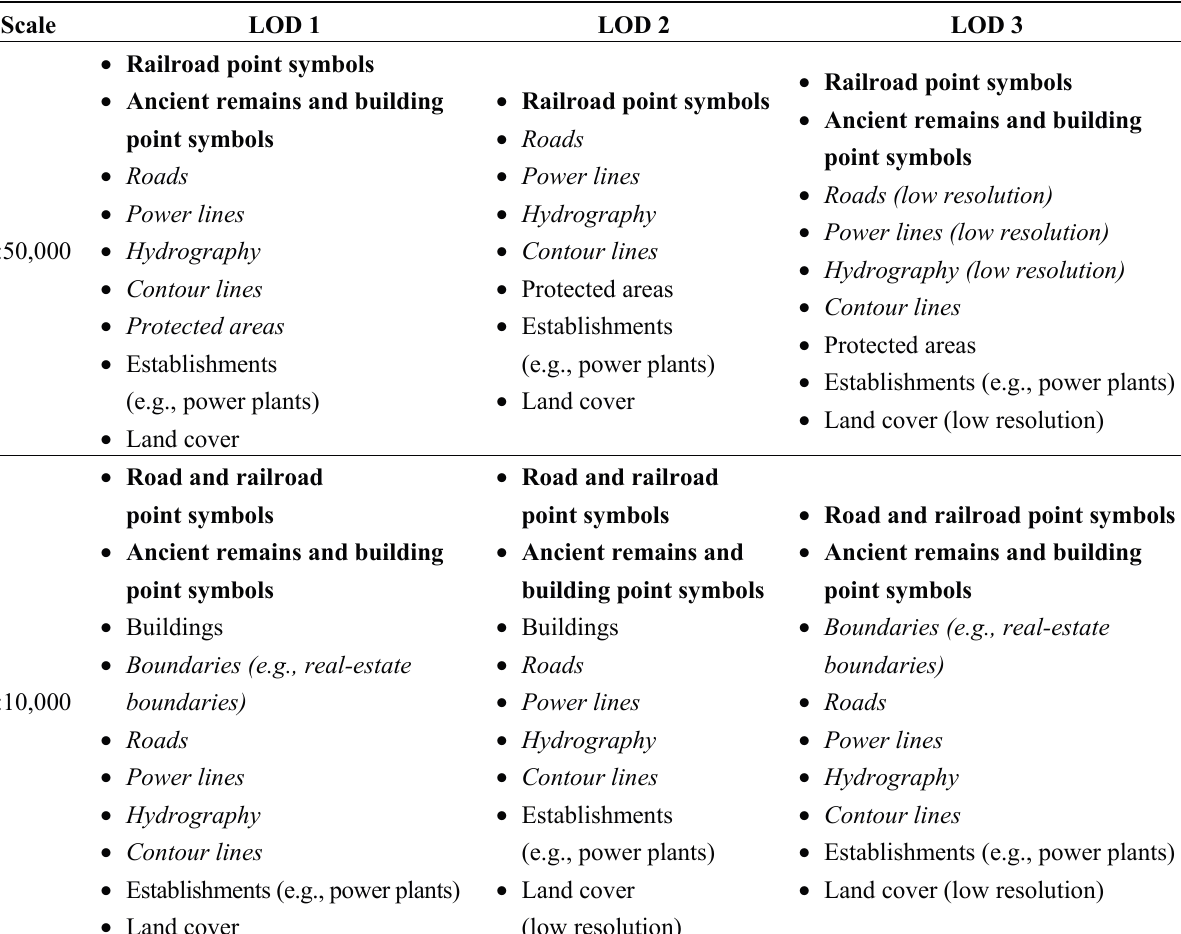
Table 1. The map information included at the three levels of detail (LOD) of the map samples. The LODs are not standard products but are collections of data layers selected to fit the purpose of this study. Point data are in bold , line data are in italics and polygon data are in normal